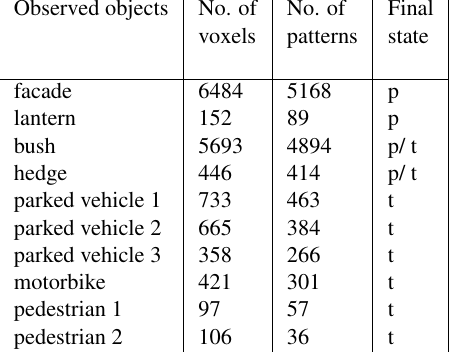
Table 1. Observed objects for state pattern analysis, final state expected to be permanent (p) or temporal